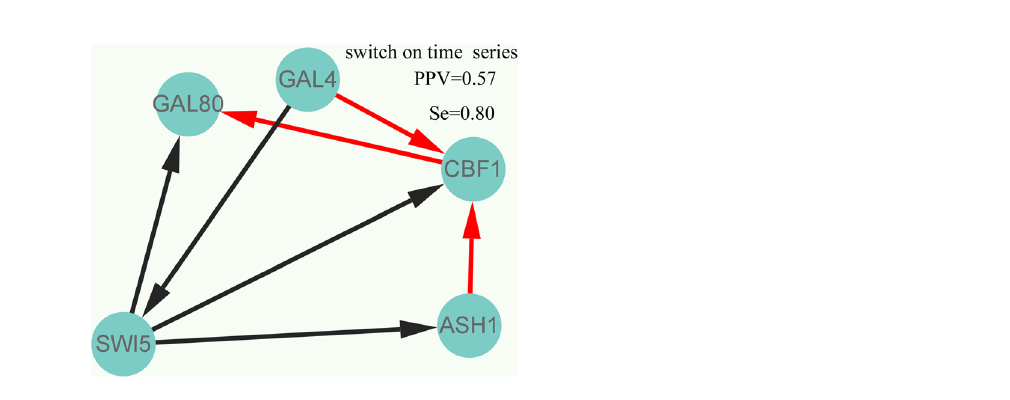
Figure 4. Reverse engineering of the IRMA gene network from time series experimental data using the GRNTSTE